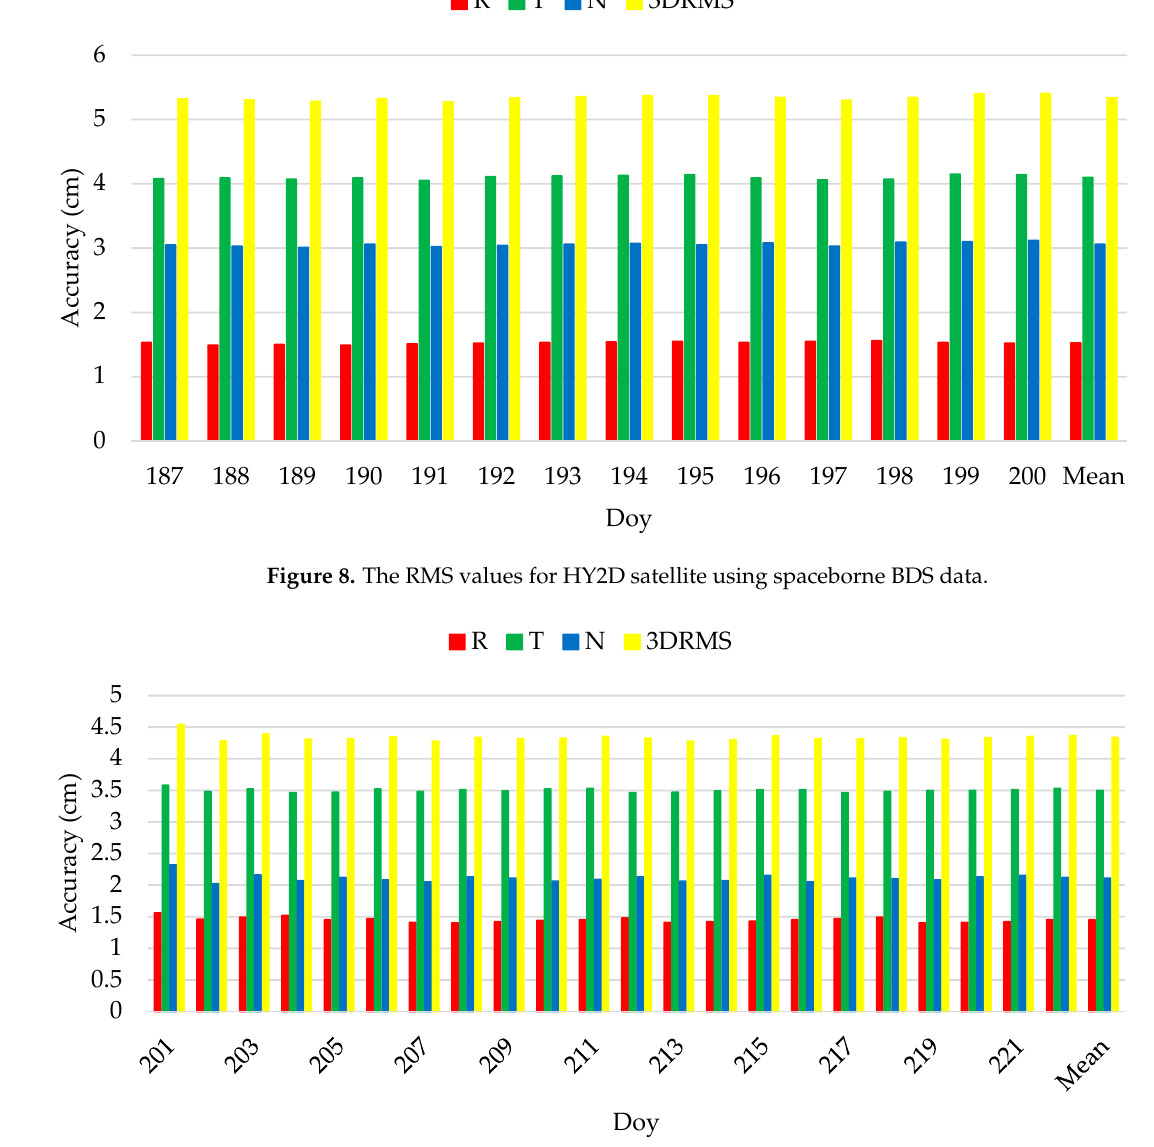
Table 6. The precision statistics of HY2D satellite using spaceborne BDS data (unit: cm).